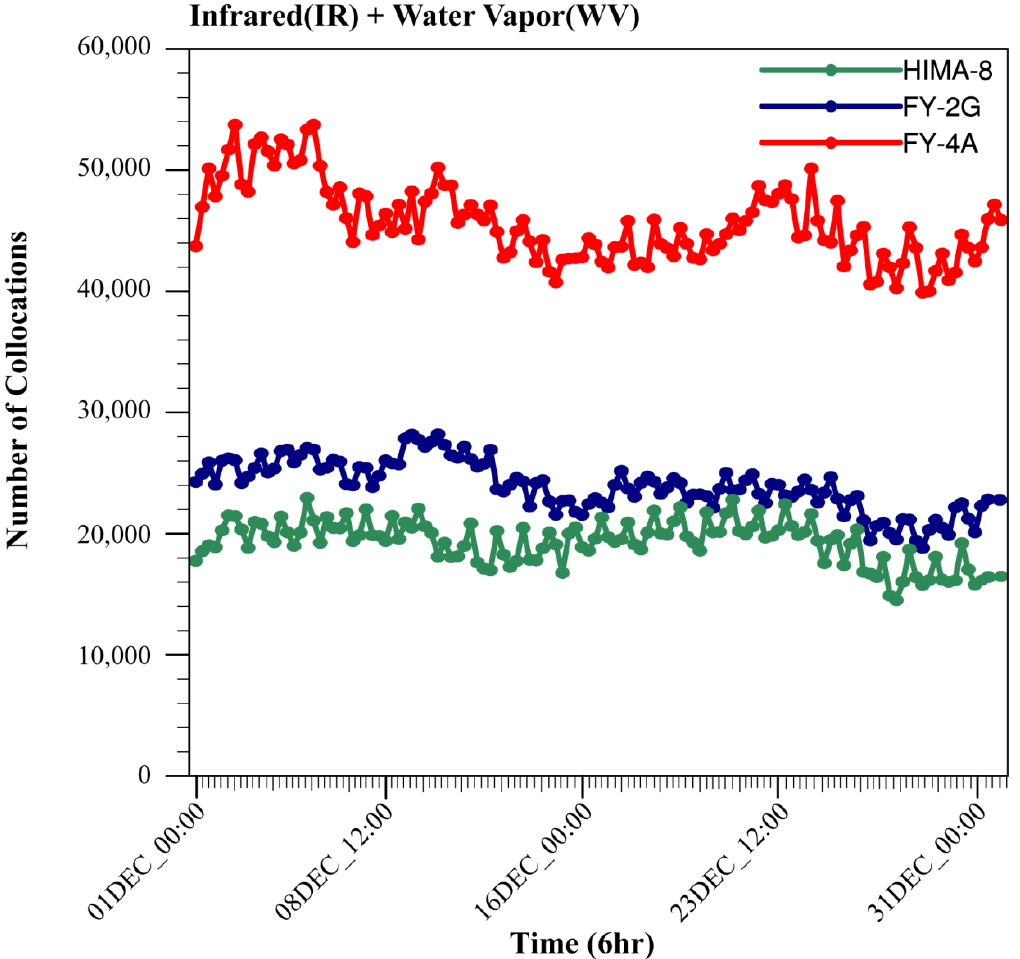
Figure 2. The time series of the observation amounts of IR and WV AMVs cover the research domain during December 2018 for 6 hourly individual times from FY-2G (blue), FY-4A (red), and HIMA-8 (green) AMVs provided by CIMSS, respectively.